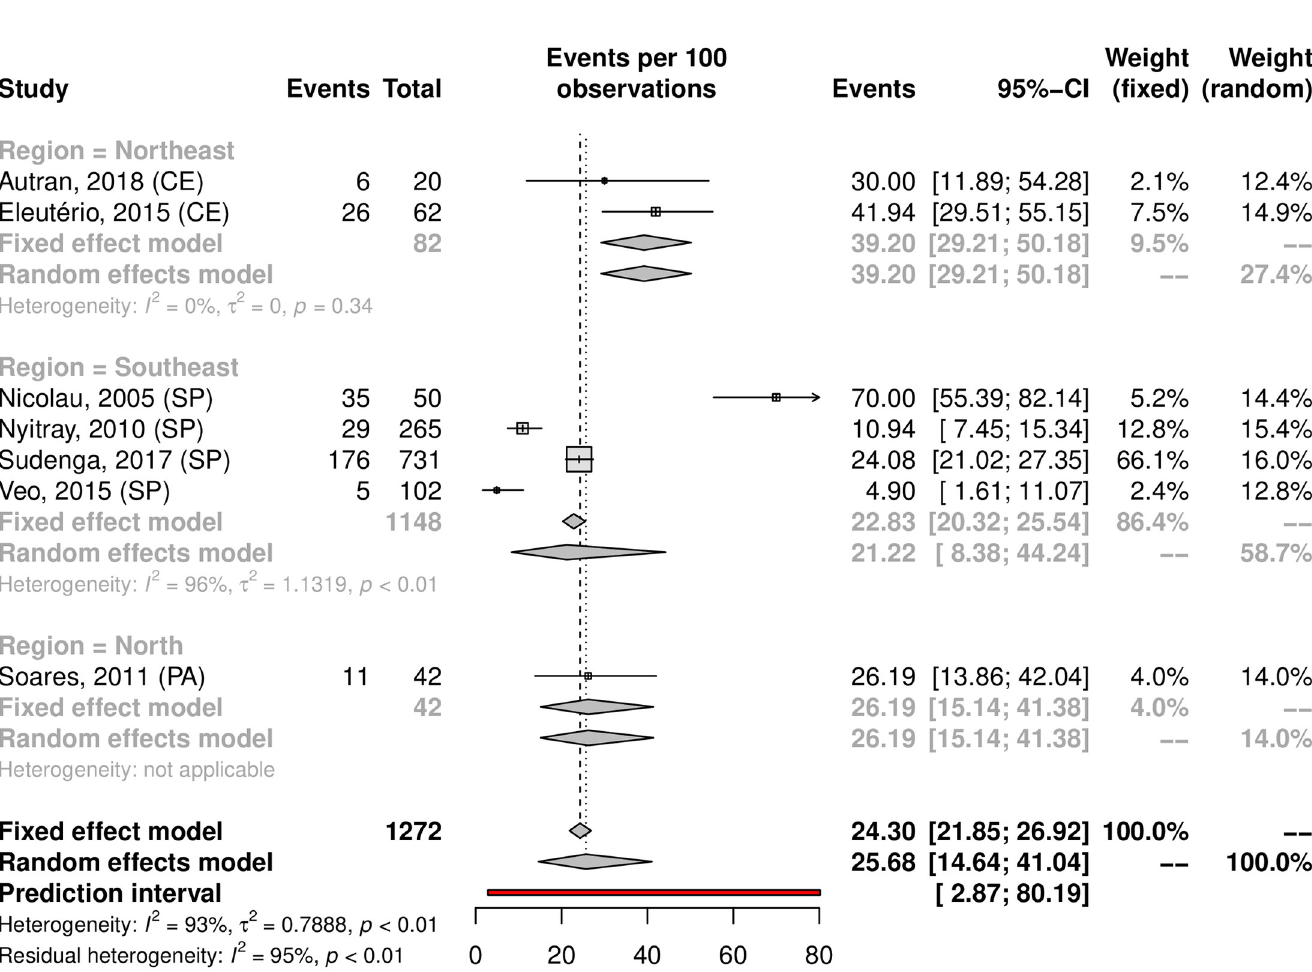
Fig 20. Prevalence of anal HPV infection in Brazil, by region. Forest plot of a metanalysis of studies reporting prevalence of anal infection by HPV, stratified by region in which each of them took place.